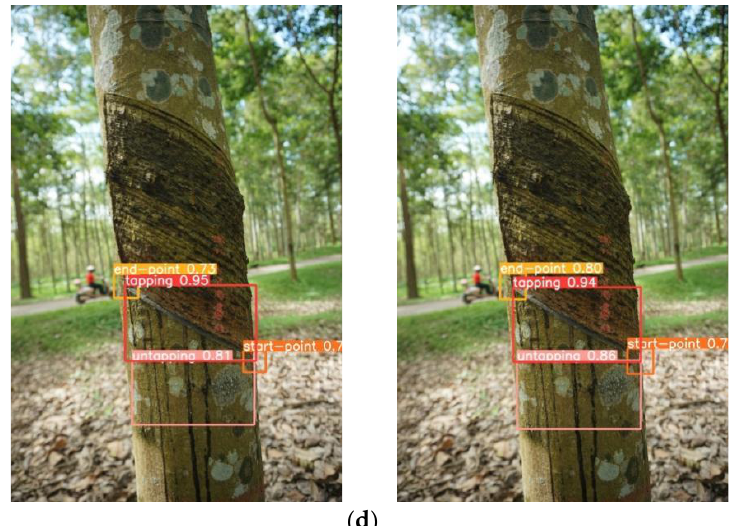
Figure 8. Detection results of two models. ( a ) Pre-tapping, ( b ) One-year tapping age, ( c ) Three-year tapping age, ( d ) Five-year tapping age.